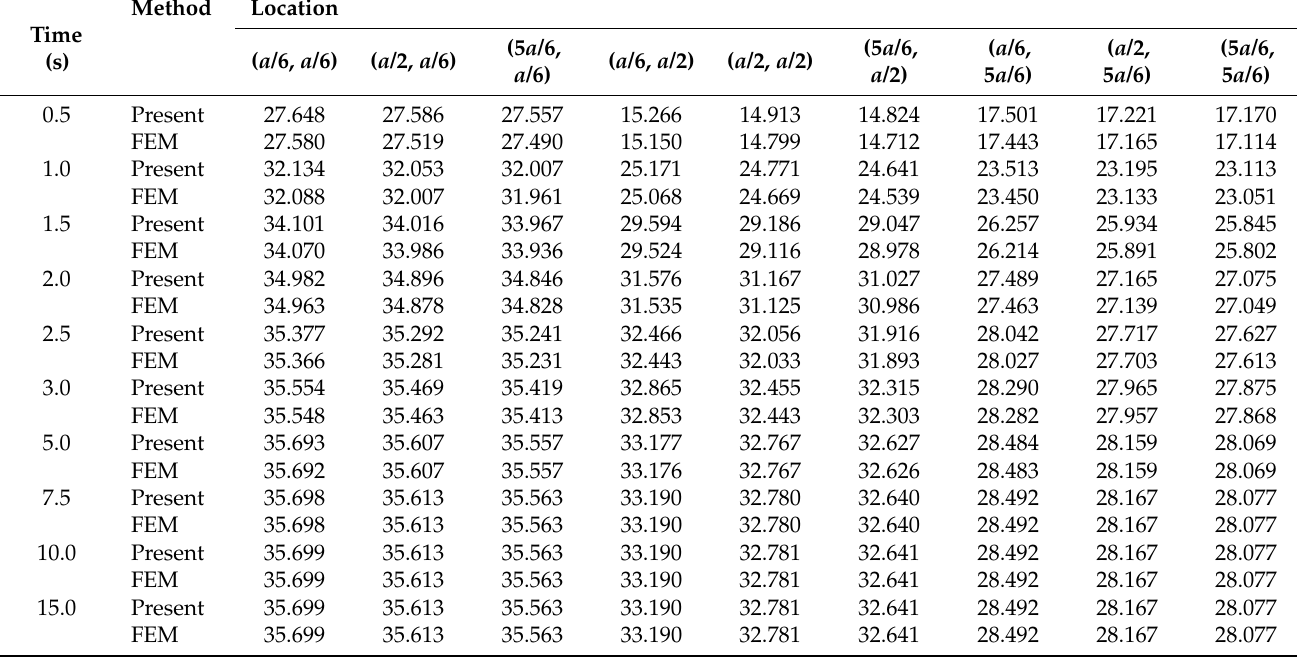
Table 2. FEM-validated temperature solutions ( o C) at different times for Case